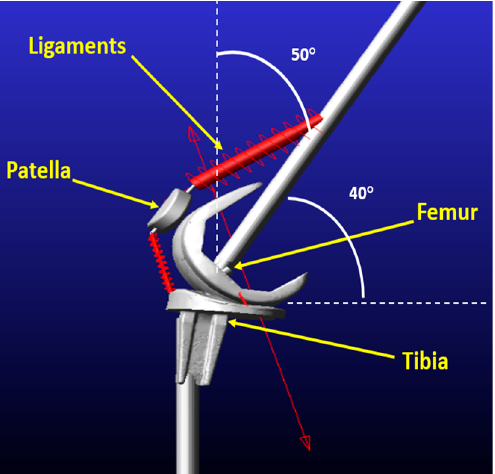
Figure 11. Multibody Model at the position 50°.